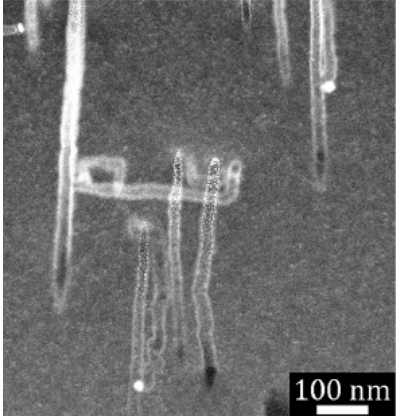
Figure 4. High-angle annular dark-field (HAADF) scanning transmission electron microscopy (STEM) image of focused ion beam (FIB)-cut cross section of a semiconductor grade moderately doped Si(110) wafer. Local etching results in the formation of crystallographically defined etch track pores primarily along {001} directions when HL MACE is performed. Copyright © 2021 Kolasinski, Unger, Ernst and Aindow. Reproduced under Creative Commons Attribution License (CC BY) from Ref. [72].